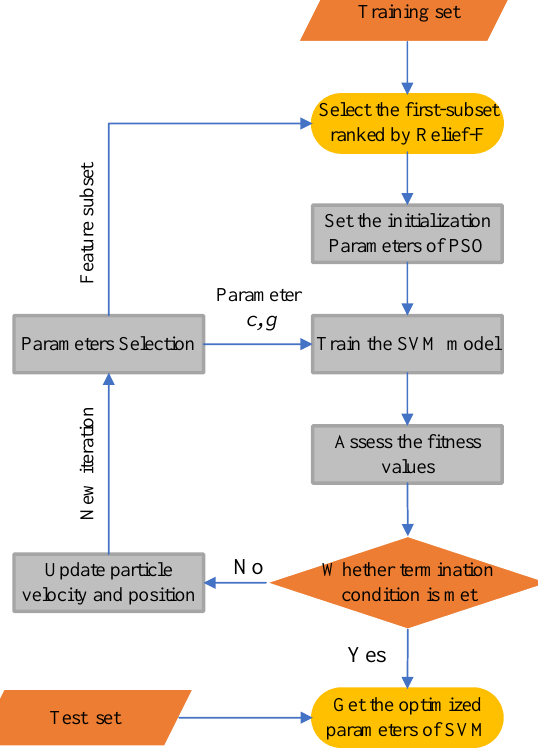
Figure 1. Algorithm flow of the hybrid optimization SVM based on Relief-F and PSO.